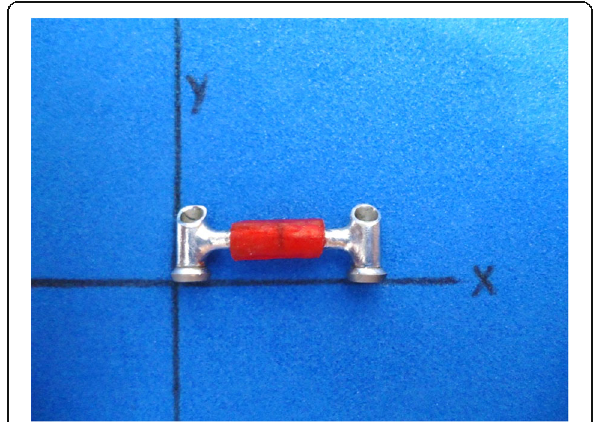
Table 2 Group description according to disinfection procedure